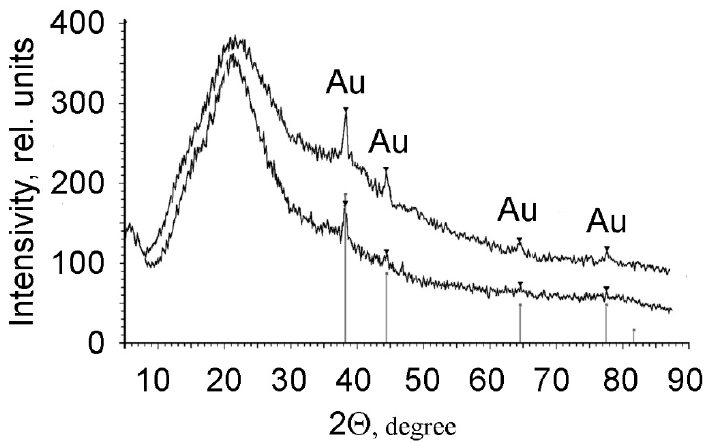
Figure 7. SAXS spectra of AuNPs size distribution for composites formed from electrolyte 3 ( a ) and electrolyte 4 ( b ).